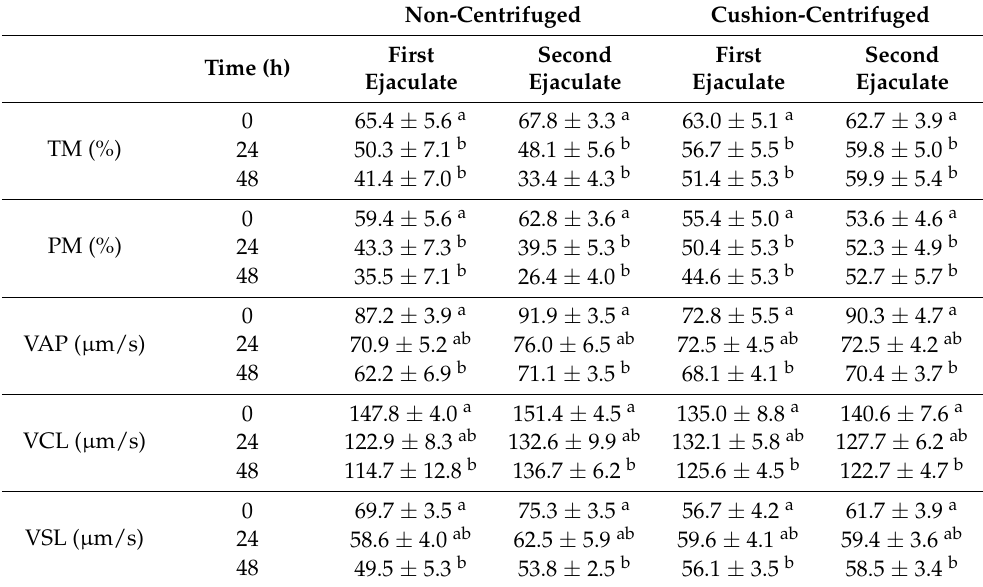
Table 8. Motility parameters of the first and second ejaculates of the season collected from breeding inactive stallions (n = 20) after 0, 24, and 48 h of